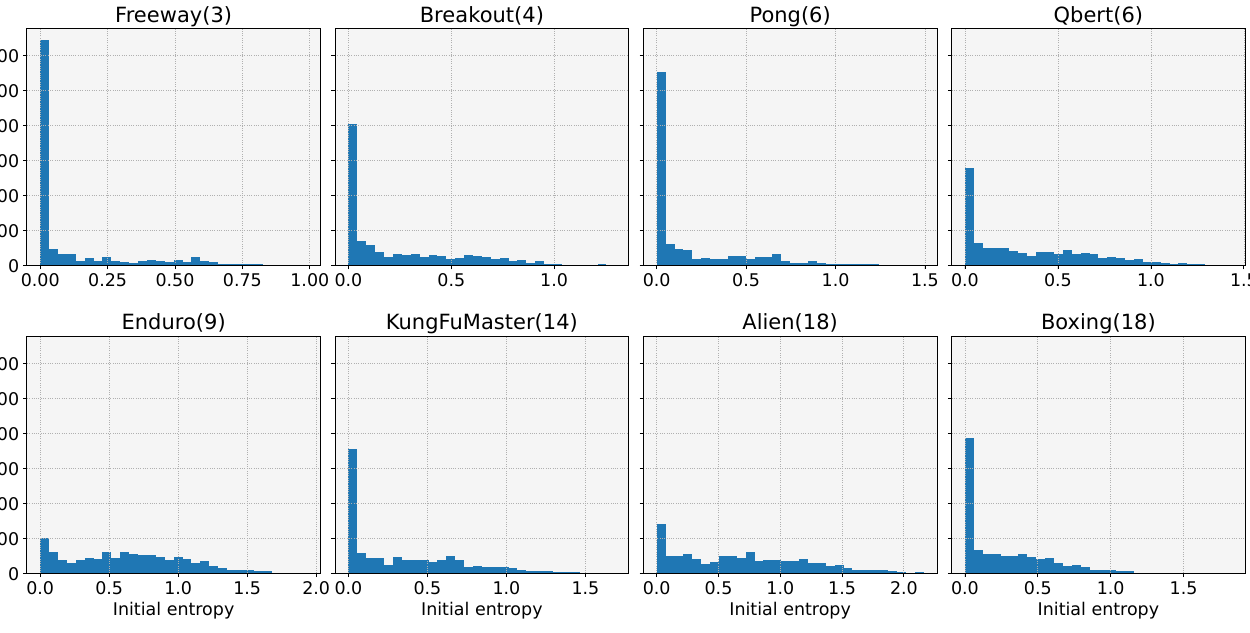
Figure 3. The histograms of the initial entropy for eight tasks. For each task, 1000 models were generated using Glorot uniform initializer with different random seeds.